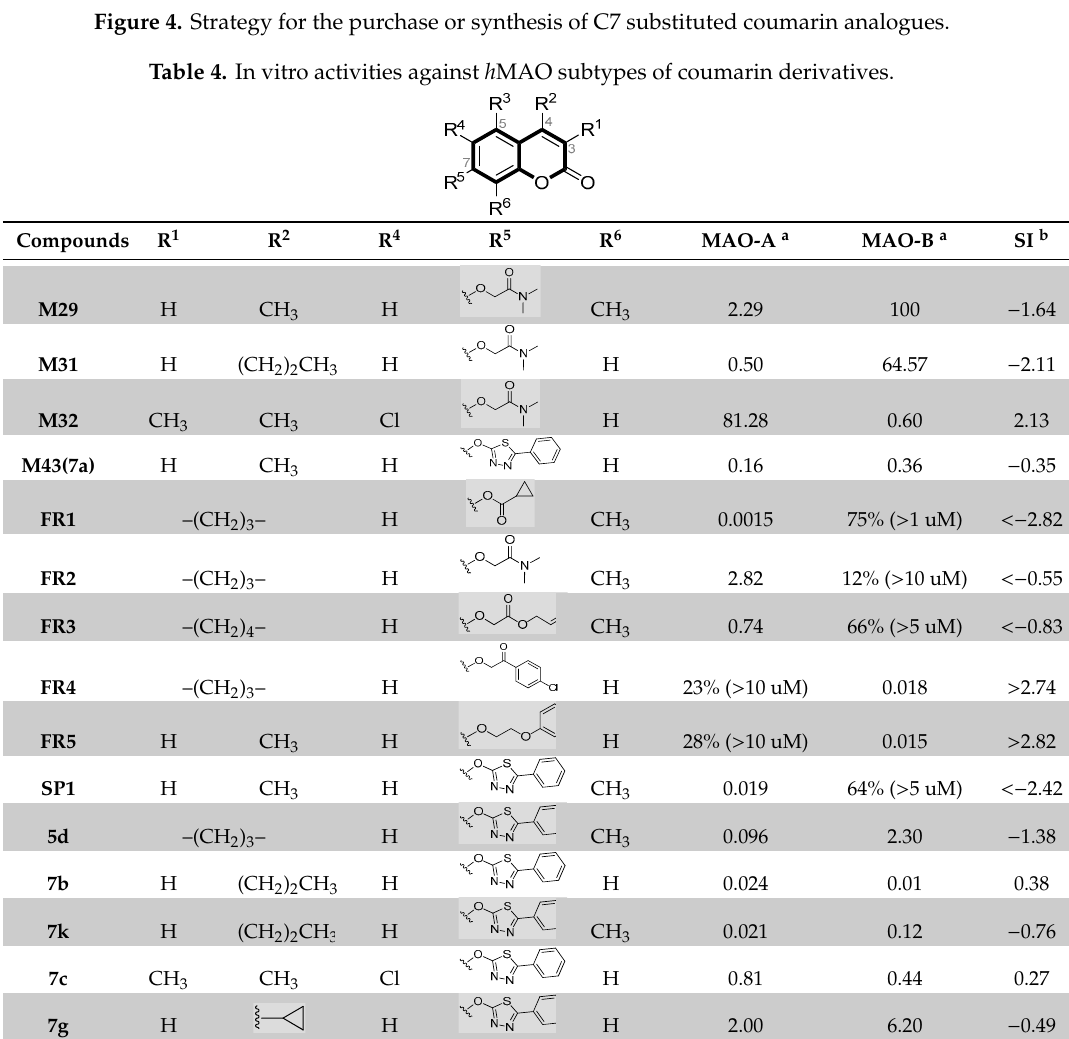
Figure 5. Structure-activity relationship (SAR)/ structure-selectivity relationship (SSR) profiles for the coumarins against h MAO subtypes based on compound M43 . 2.4. In Silico Pharmacokinetic Properties Additionally, in silico pharmacokinetic properties of all the tested C7-substituted coumarin derivatives were evaluated using ACD/percepta platform including lipophilicity logP, molecular weight, Lipinski’s rule of five, lead-like, Caco-2 and CNS properties. Detailed pharmacokinetic properties were presented in Table 5 [35]. According to the predicted properties, all these compounds complied with the Lipinski’s rule without any violation, which suggested that these new C7- substituted coumarin analogues might have good oral bioavailability. The Caco-2 permeability model was used to predict the absorption potential of oral drugs. The theoretical results suggested that most of these compounds possessed good intestinal permeability. A CNS penetration model was also applied suggesting the ability of these compounds to cross the blood–brain-barrier (BBB). These results suggested that the compounds might have the ability to pass the BBB, which is essential factor for MAO inhibition in human brain. In addition, a CYP isozymes inhibition model was applied for these derivatives using CypRules Server, which suggested that they do not inhibit the five CYP450 enzymes (CYP1A2, CYP2C19, CYP2C9, CYP2D6 and CYP3A4) [36]. Table 5. Calculated physicochemical and pharmacokinetic parameters. Compounds logP